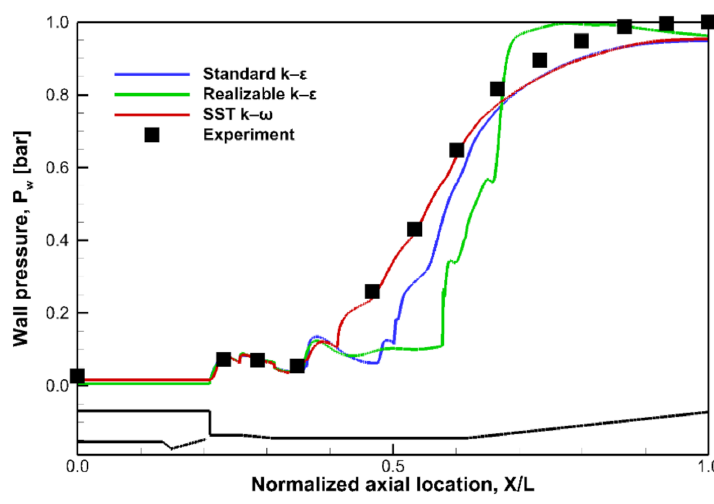
Figure 3. Diffuser wall pressure at P 0 = 50 bar for various turbulence